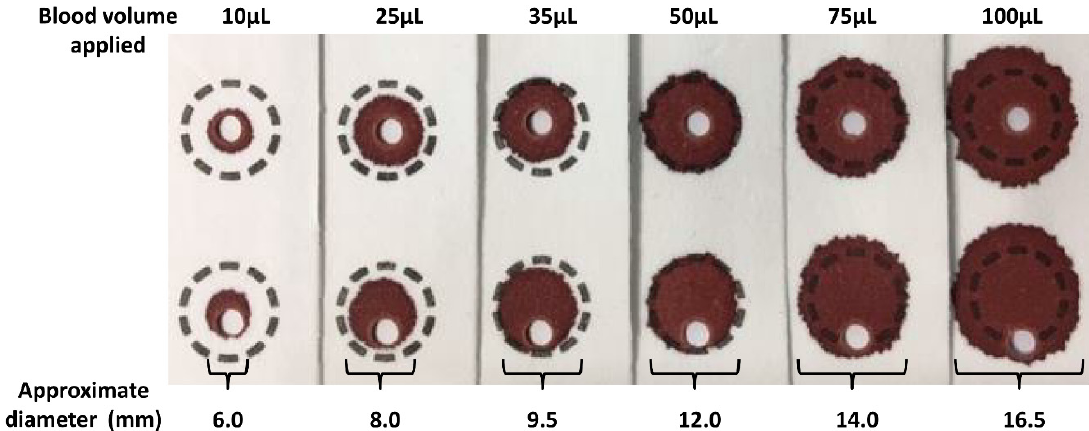
Figure 2. Relationship between volumes of blood applied to the filter paper collection devices and the measured dried blood spot (DBS) diameter. Results shown are the mean of the diameter measurements (results from [25,39]). Sub-punches (3.2 mm) were taken from central (first row) and peripheral locations (second row).